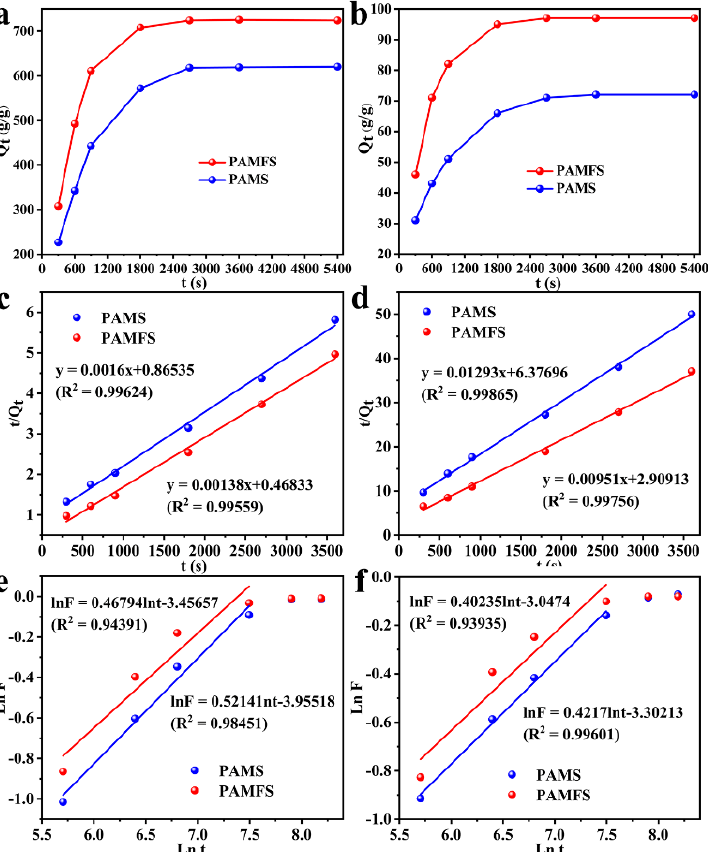
Figure 4. Swelling kinetic curves of PAMFS and PAMS in distilled water ( a ), t/Q t vs. t graphs in distilled water ( c ), fitting curve of LnF vs. Lnt in distilled water ( e ), swelling kinetic curves of PAMFS and PAMS in 0.9 wt% NaCl solution ( b ), t/Q t vs. t graphs in 0.9 wt% NaCl solution ( d ) and LnF vs Lnt in 0.9 wt% NaCl solution ( f ).